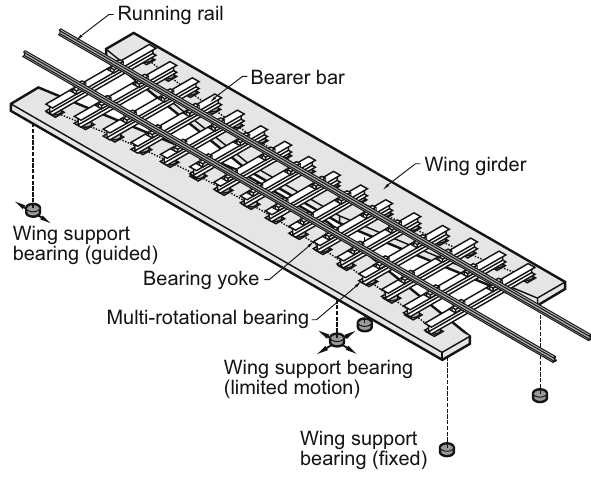
Fig. 4 Three-beam system for accommodating track Fig. 5 Schematic of the CESuRa